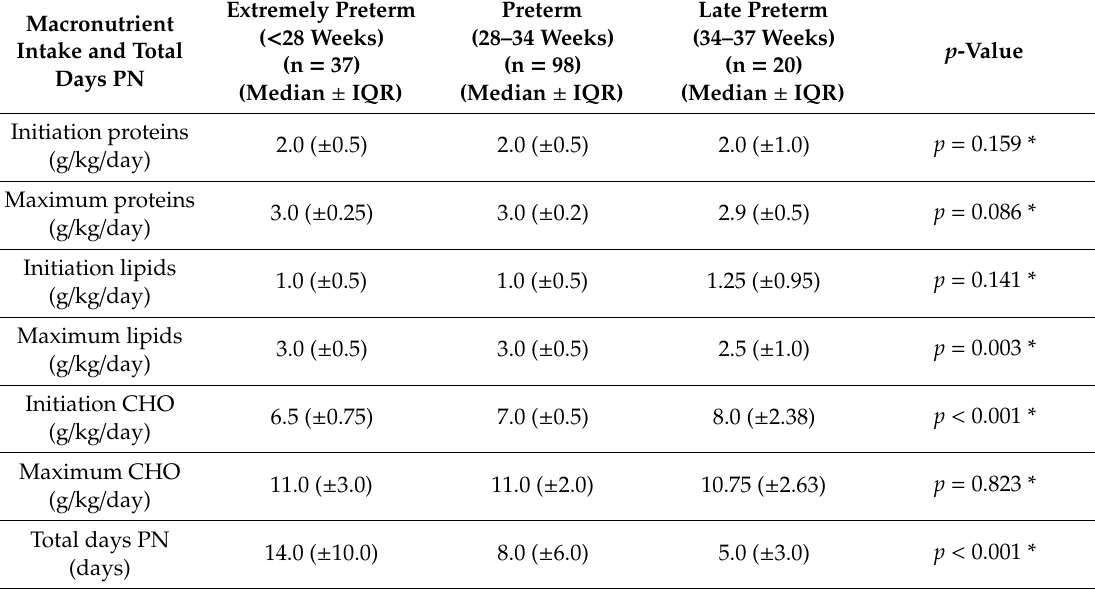
Table 4. Distribution of prescribed macronutrient intake according to gestational age.